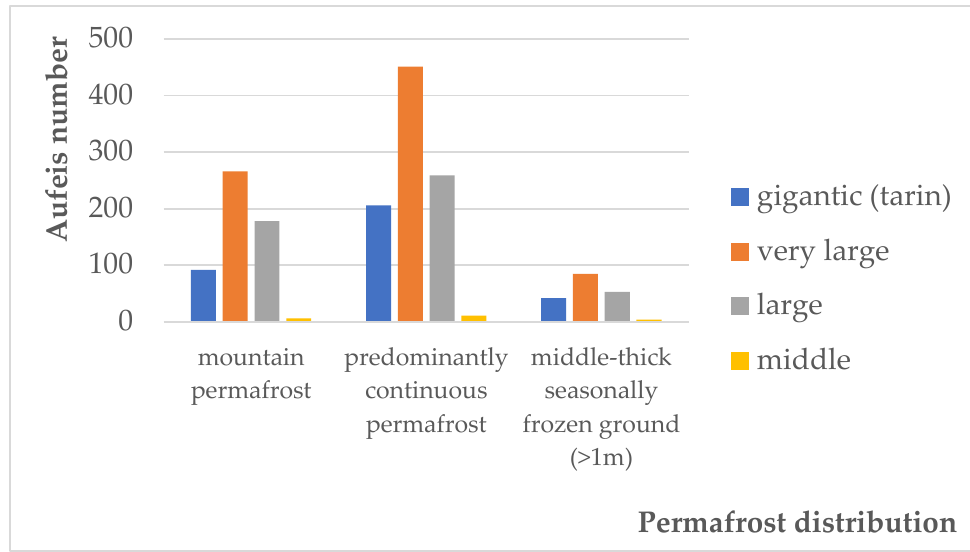
Figure 9. Plot of Aufeis number versus types of permafrost distribution in the Kunlun Mountains.